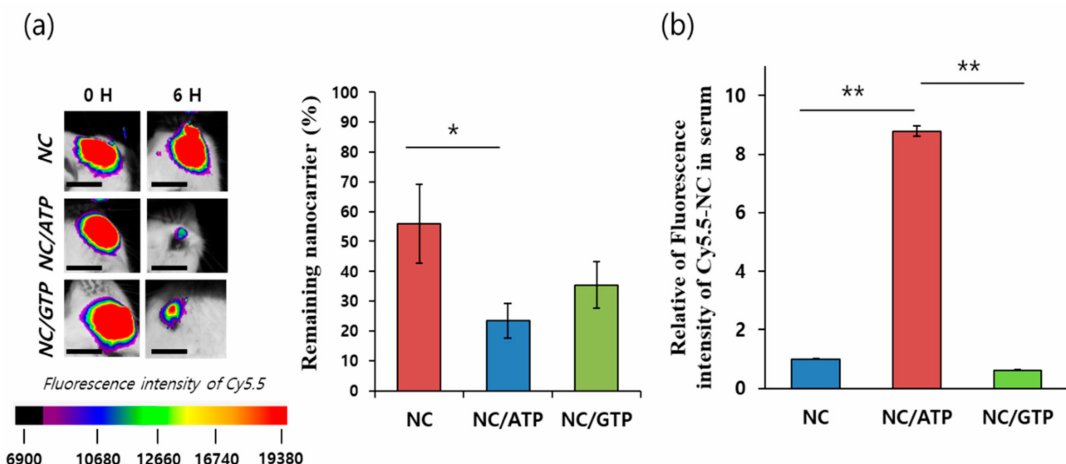
Figure 4. In vivo ( a ) retention of Cy5.5–NC or Cy5.5–NC–ATP in the eyes by fluorescence intensity at 6 h compared with the initial values (scale bar: 3 µ m), and ( b ) permeated Cy5.5–NC or Cy5.5–NC–ATP in the serum 6 h after intraocular administration ( n = 3). Statistical analysis by t -test. *: p ≤ 0.05; **: p ≤